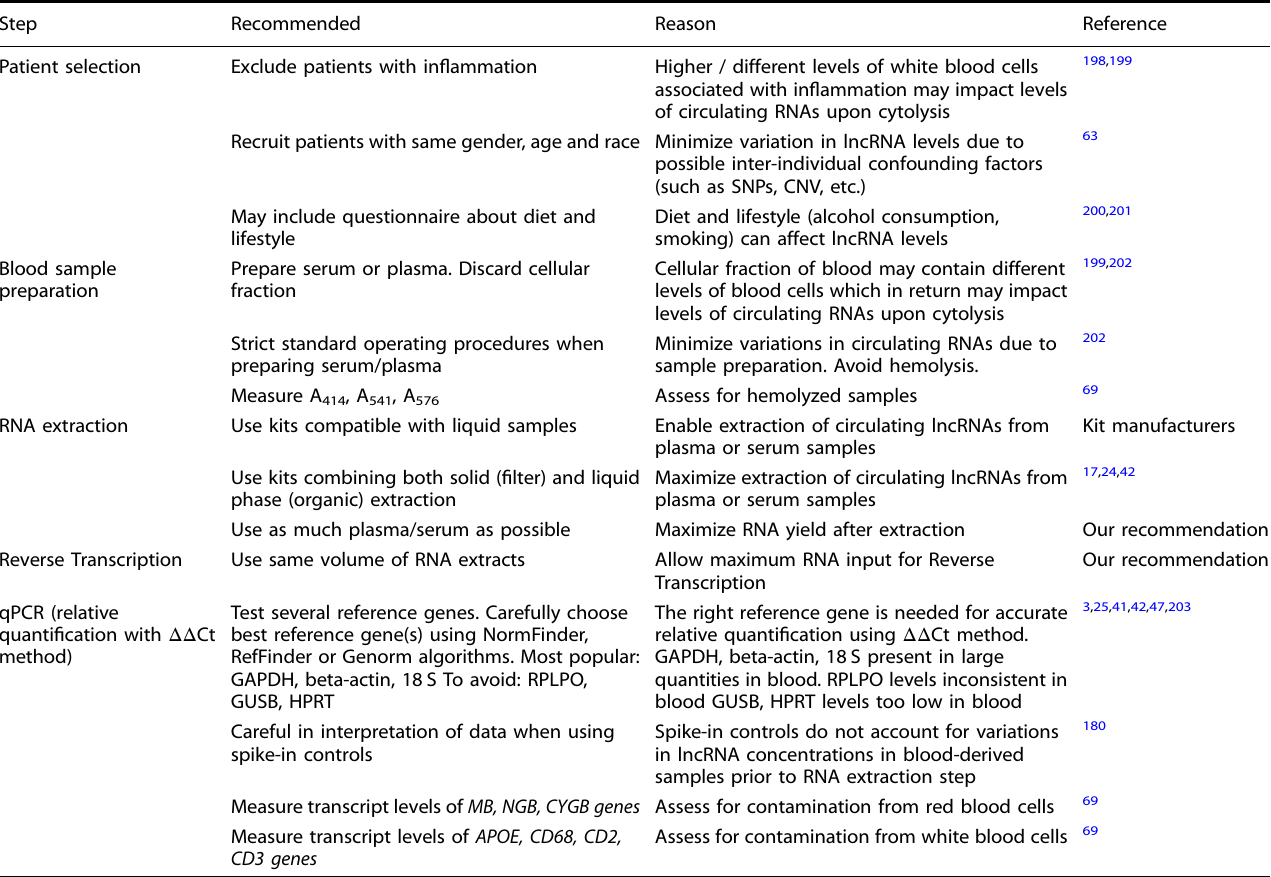
Table 3. Guidelines recommended for the study of circulating lncRNAs as biomarkers for cancer diagnosis, based on troubleshooting performed by previous